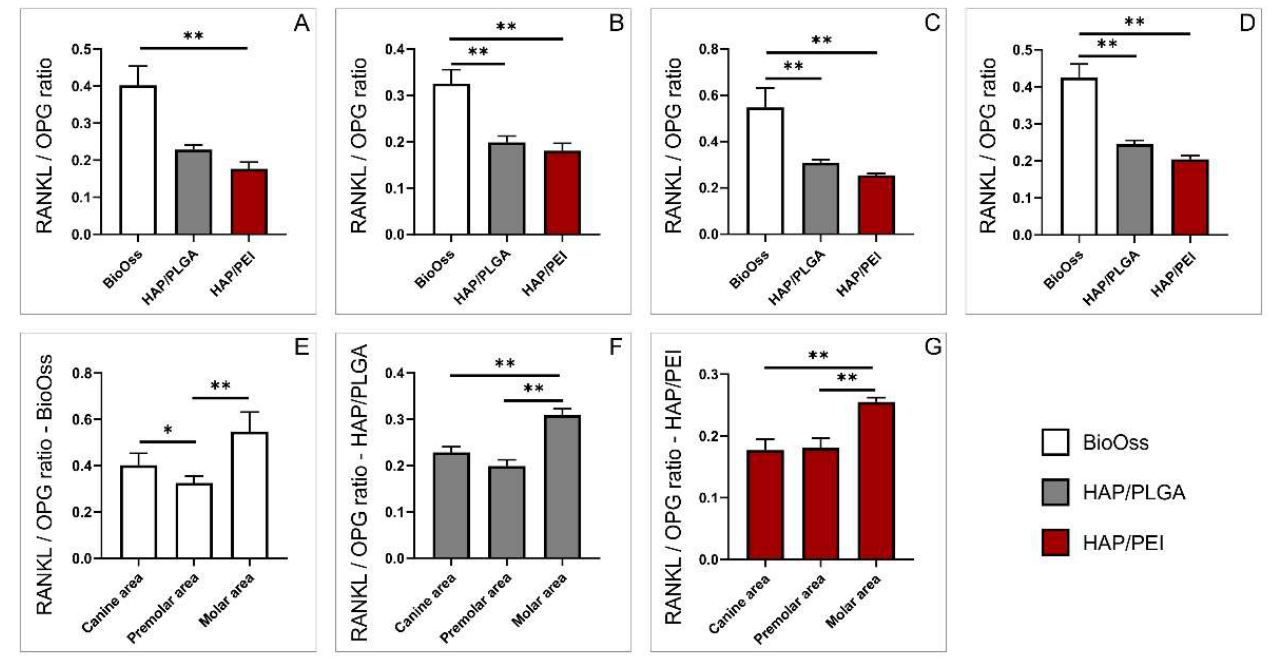
Figure 8. The RANKL/OPG ratio: ( A ) canine area, ( B ) premolar area, ( C ) molar area, ( D ) whole mandibula, ( E ) BioOss graft, ( F ) HAP/PLGA graft, ( G ) HAP/PEI graft. The values are mean ± standard error of the mean (SEM), * denotes a significant difference p < 0.05, ** denotes a significant difference p < 0.01.